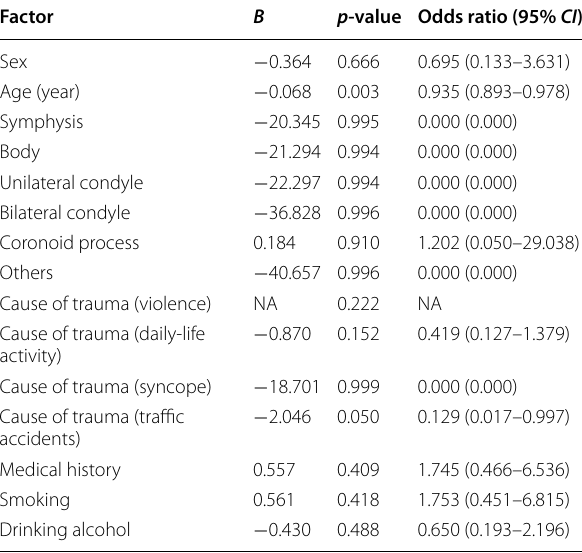
Table 7 Logistic regression analysis of patients with